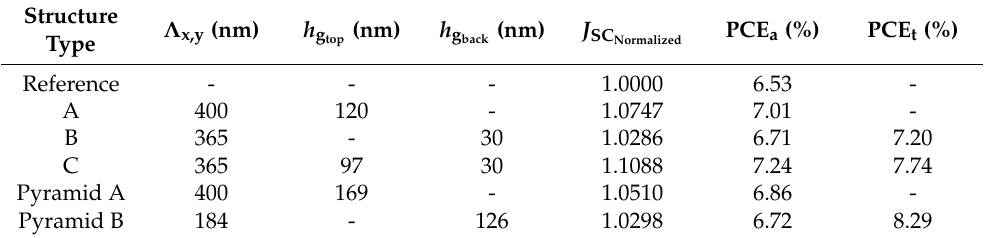
Table 1. Optimized grating parameters, normalized short-circuit current density, and power con- version efficiency (PCE) of the studied structures. The normalization is relative to the short-circuit current density of the reference structure. PCE a considers only the absorption in the smooth active layer; PCE t considers the absorption in the smooth active layer and that of the absorbing material in the back grating